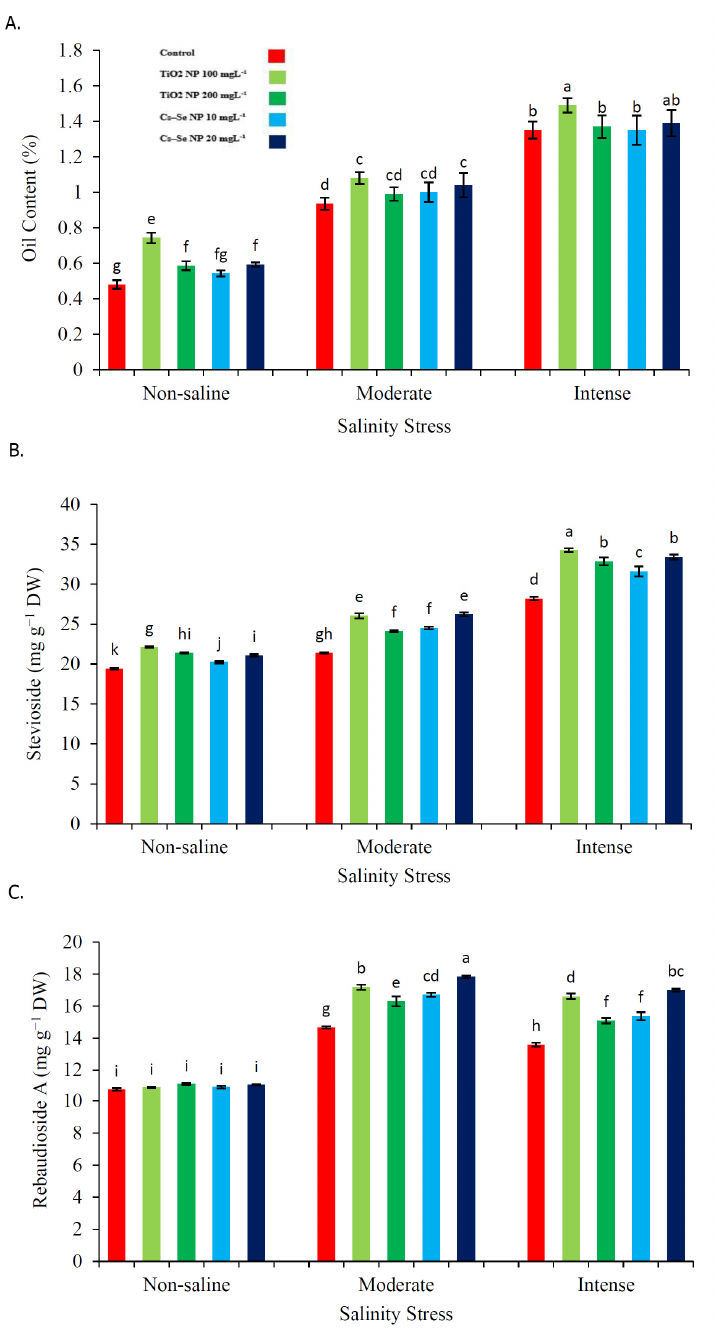
Figure 5. Effect of different concentrations of Cs–Se NPs and TiO 2 NPs on the oil content ( A ), stevioside ( B ) and rebaudioside A ( C ) of stevia ( Stevia rebaudiana Bertoni) leaves under salinity stress. Data are the average of 3 repetitions ± standard error. Different letters indicate significantly different values according to Duncan’s post hoc analysis at p <